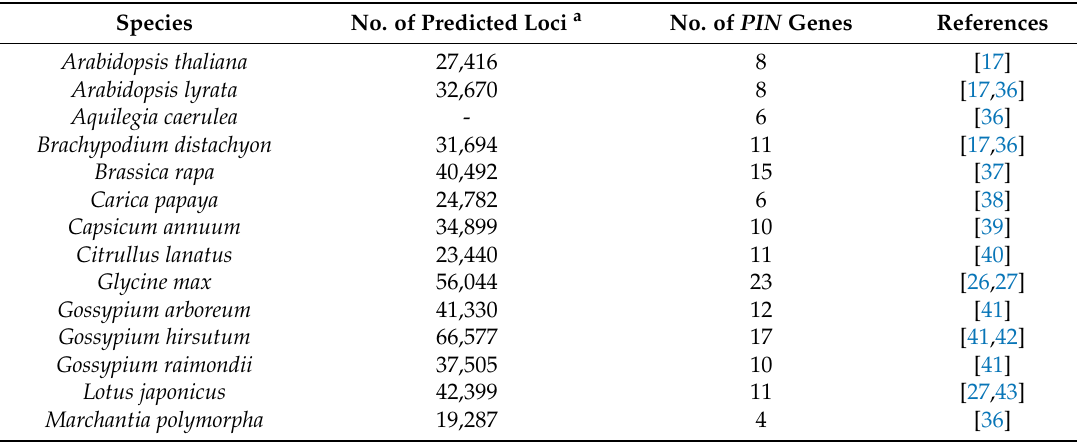
Table 1. Summary of PIN genes in 31 plants found by genome-wide analysis.